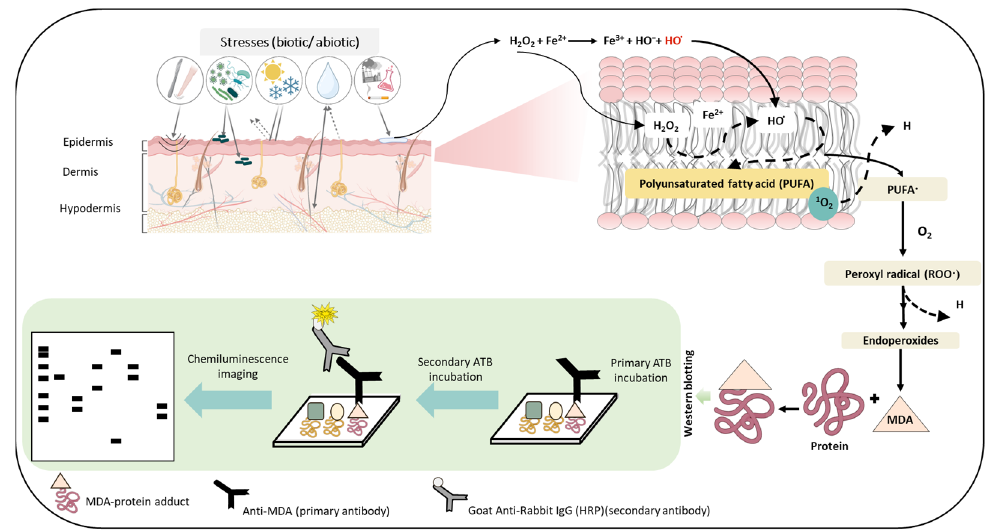
Figure 7. Schematic representation depicting the steps involved in the formation of the MDA-protein adduct as the consequence of ROS generation and successive oxidative radical reactions. The figures show stress factors (biotic and abiotic) that can lead to the formation of ROS which eventually can lead to lipid peroxidation and subsequently to the generation of the MDA-protein adduct. The lower panel depicts the use of immunoblotting techniques to detect MDA- protein formation.